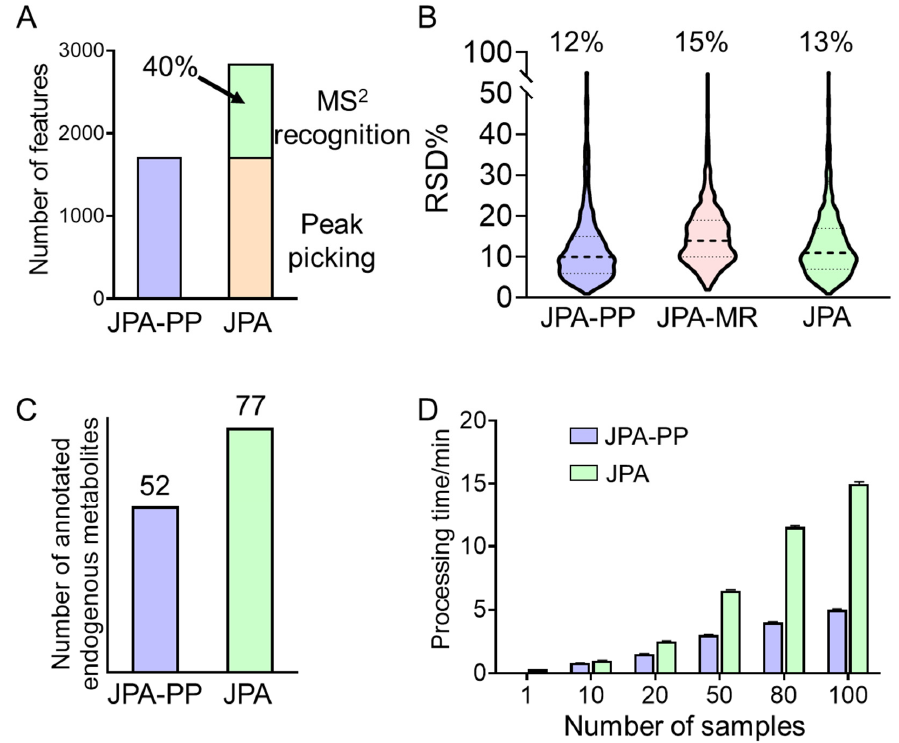
Figure 4. Comparison of original urine data in RP(+) mode processed by JPA-PP and JPA-MR in ( A ) number of features, ( B ) quantitative precision, ( C ) number of annotated endogenous metabolites, and ( D ) processing time.